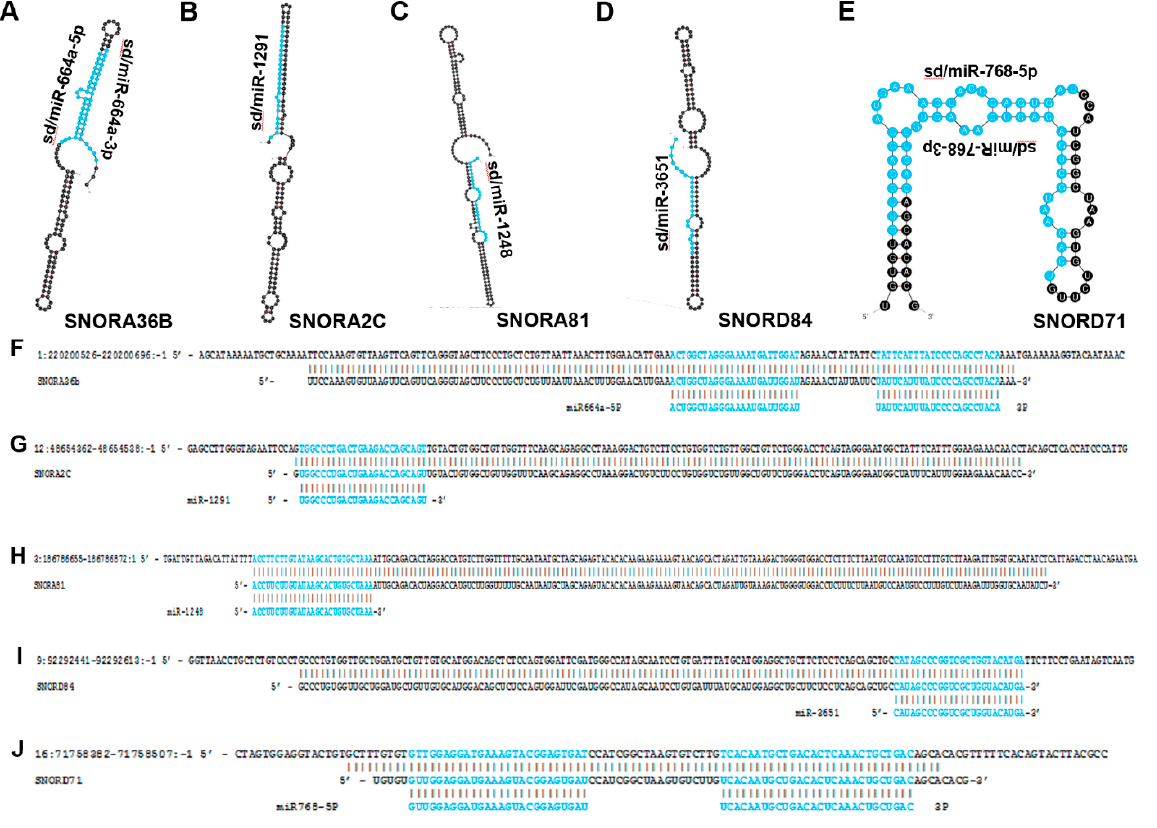
Figure 4. miRNAs that arise from snoRNA transcripts. The most thermodynamically stable sec- ondary structures of snoRNA transcripts were generated by mfold [20]. Annotated miRNA se- quences embedded in these transcripts are highlighted in blue ( A – E ). ( A ) miR-664a is embedded within the SNORA36B transcript and has been shown to function as a tumor-suppressing RNA in HCC and some types of cervical cancer while also functioning as a tumor-promoting RNA in cer- vical squamous cell carcinoma [56]. ( B ) miR-1291 is located within the SNORA2C transcript and is characterized as a tumor-suppressing RNA in pancreatic, prostate, breast and renal cell carcinoma [59–63]. ( C ) miR-1248 is derived from SNORA81 and has been determined to be upregulated in prostate cancer [64]. ( D ) miR-3651 is embedded within SNORA84 and is upregulated in colorectal cancer but downregulated in esophageal cancer [65,66]. ( E ) miR-768 resides within the SNORD71 transcript and has been shown to be downregulated in lung, breast, ovary, liver, parotid gland, thyroid gland cancers and melanoma [67–69]. ( F – J ) Mature miRNA sequences (highlighted in blue) were aligned to their corresponding snoRNA precursor transcripts and snoRNAs were aligned to their respective genomic regions. ( F ) Alignment between human genome (GRCh38: chr1:220200526-220200696:-1) ( top ), SNORA36B (ENSG00000222370) ( middle ), and miR664a (ENSG00000281696) ( bottom ). ( G ) Alignment between human genome (GRCh38: chr12:48654362-48654538:-1) ( top ), SNORA2C (ENSG00000221491) ( middle ) and miR-1291 (ENSG00000281842) ( bottom ). ( H ) Alignment between human genome (GRCh38: chr 3:186786655-186786872:1) ( top ), SNORA81 (ENSG00000221420) ( middle ), and miR-1248 (ENSG00000283958) ( bottom ). ( I ) Alignment between human genome (GRCh38: chr 9:92292441-92292613:-1) ( top ) SNORA84 (ENSG00000239183) ( middle ) and miR-3651 (ENSG00000281156) ( bottom ). ( J ) Alignment between human genome (GRCh38: chr 16:71758382-71758507:-1) ( top ), SNORD71 (ENSG00000223224) ( middle ) and miR-768 (ENSG00000223224) ( bottom